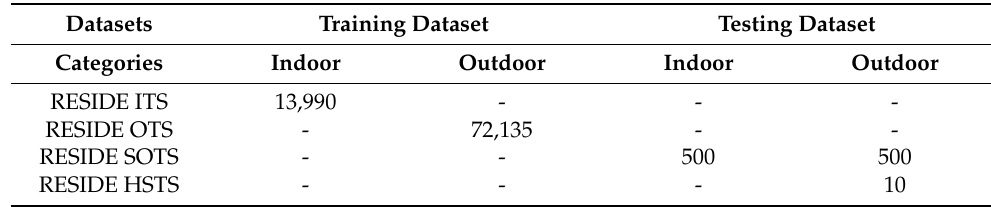
Table 3. Distribution of the dataset.